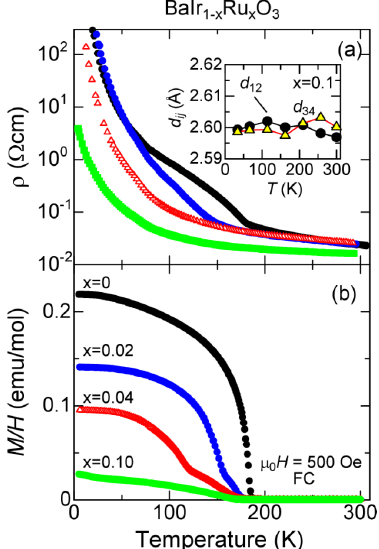
Figure 5. The impurity effect on the 182-K transition. ( a ) resistivity ρ of polycrystalline samples of BaIr 1 − x Ru x O 3 . The inset shows the intra-trimer Ir-Ir bond lengths for the x = 0.1 sample. The two trimers have the identical, temperature-independent bond length; ( b ) magnetization M divided by an external field H of 500 Oe of the same